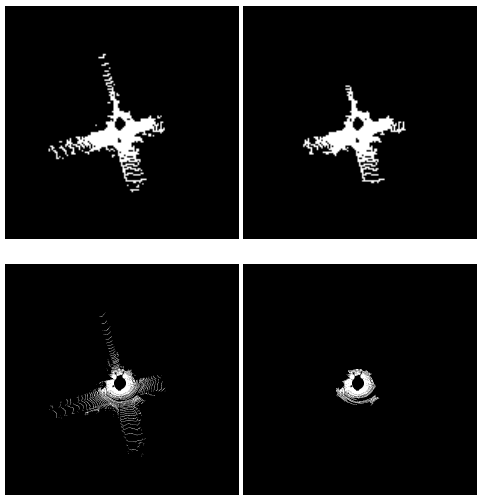
Figure 2. Ground disconnection caused by peripheral lower density. Ground detected (right) by the method described in (Hern´andez and Marcotegui, 2009) and its corresponding ground truth (left). Two different resolutions: pixels of 1 m side (first row) and 20 cm side (second